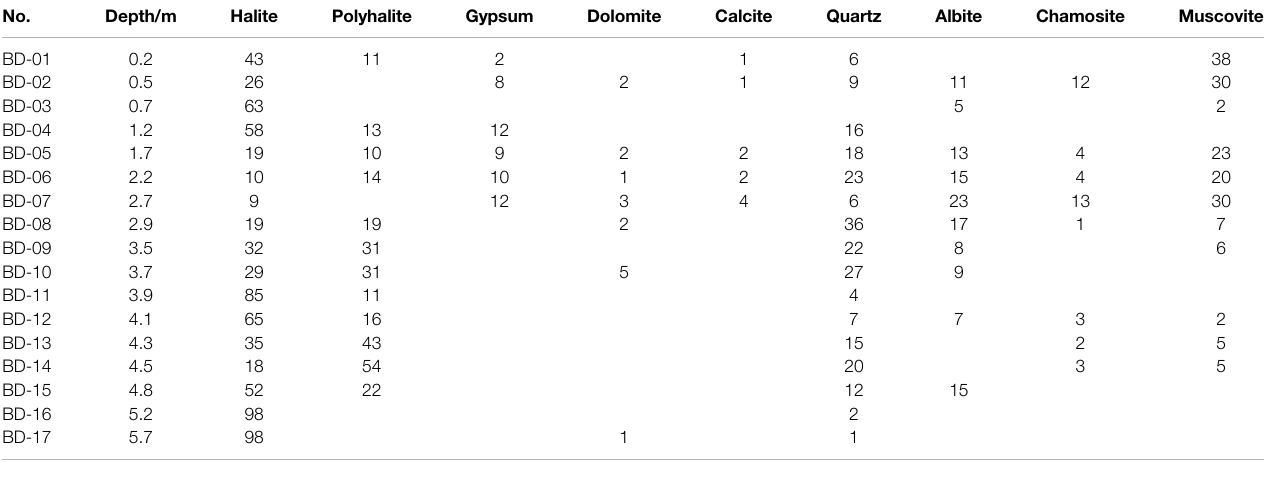
TABLE 1 | Components of minerals of seventeen samples in study area (%).